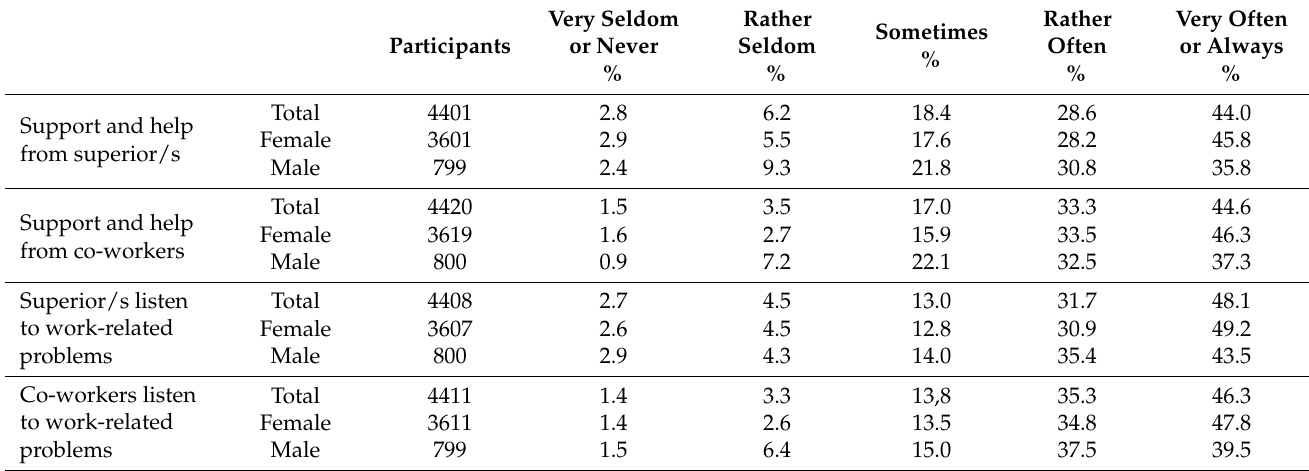
Table 1. Social support at work by gender.